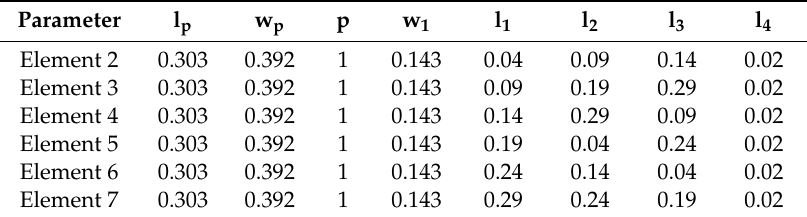
Figure 1. ( a ) Geometrical construction of the element. ( b ) Geometrical construction of the phase shifter. Table 1. Parameters of the element and phase shifter (unit: mm).